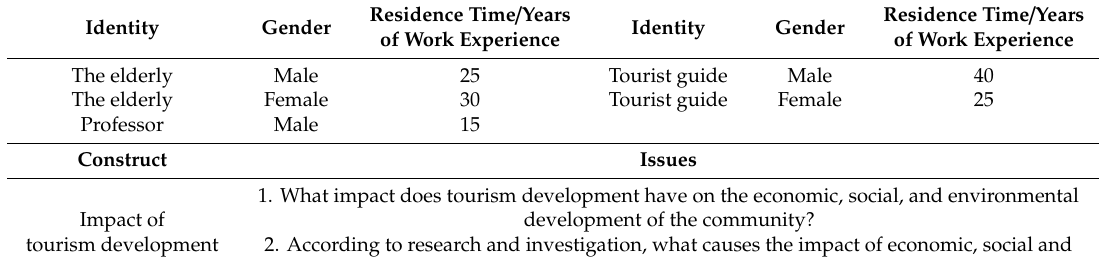
Table 3. Background information of the interviewees and outline of the